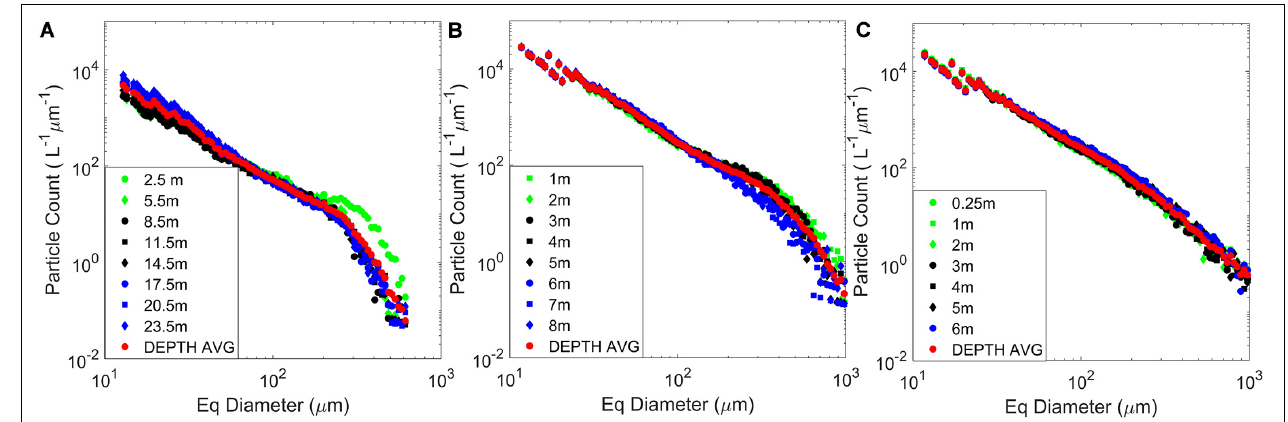
FIGURE 4 | Depth-binned and depth-averaged particle size distributions (PSDs) obtained from vertical profiles of a holographic imaging system during two field experiments at East Sound, Washington, in September 2015 and at Lake Erie in August 2014. Figure adapted from data presented in Moore et al. (2017) and Nayak et al. (2018a; 2018b). (A) The East Sound profile was recorded during the presence of a “thin layer” of diatoms, dominated by Ditylum brightwelli ; (B) Data recorded during a Microcystis aeruginosa bloom in western Lake Erie; and (C) PSDs at Lake Erie in a water mass dominated by the cyanobacteria Planktothrix aghardii